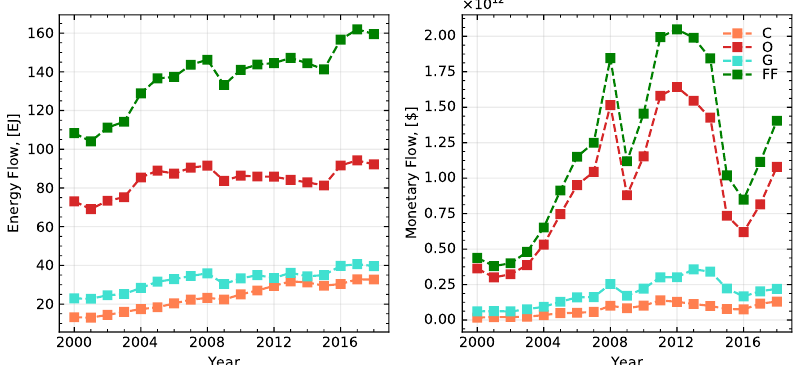
Figure 7. The evolution of fossil fuel trade in energy (Exajoules = 10 18 J (cid:39) 10 15 Btu ) and monetary (USD 10 12 ) terms.